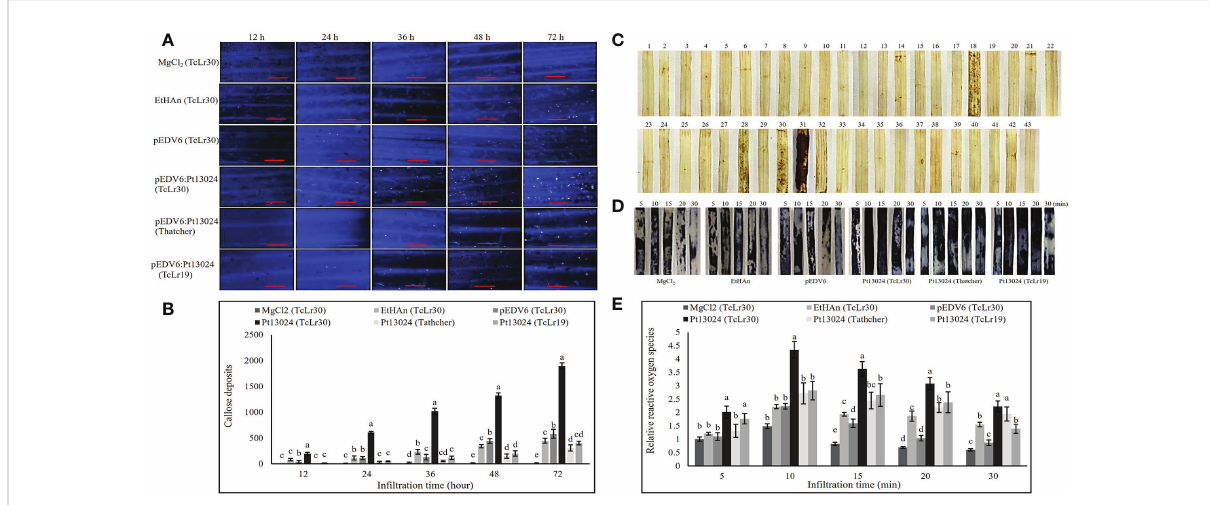
FIGURE 6 Transient expression of Pt13024 stimulated callose deposition and caused a burst of ROS in TcLr30. (A) Callose deposition at different time points after overexpression of Pt13024 in Thatcher, TcLr19, and TcLr30, respectively. The controls were MgCl 2 , EtHAn, and pEDV6. Bar = 100 m m. (B) Callose deposition associated with in fi ltration time. The accumulation of callose deposition was counted by the area using Image-Pro Plus 6.0 software. The area of callose deposition was measured in pixels. (C) The effector proteins were delivered into the Thatcher and 42 wheat leaf rust resistant near-isogenic lines (monogenic lines) by the bacterial type III secretion system. The sequence of wheat materials was 1, Thatcher; 2, TcLr1; 3, TcLr2a; 4, TcLr2b; 5, TcLr2c; 6, TcLr3; 7, TcLr3ka; 8, TcLr3bg; 9: TcLr9, 10: TcLr10; 11: TcLr11; 12, TcLr12; 13, TcLr13; 14, TcLr14a; 15, TcLr14b; 16, TcLr15; 17, TcLr16; 18, TcLr17; 19, TcLr18; 20, TcLr19; 21, TcLr20; 22, TcLr21; 23, TcLr22, 24, TcLr23, 25, TcLr24, 26, TcLr25, 27, TcLr26, 28, TcLr27+31, 29, TcLr28; 30, TcLr29, 31, TcLr30, 32, TcLr32, 33, TcLr33, 34, TcLr34, 35, TcLr35, 36, TcLr37; 37, TcLr38, 38, TcLr41, 39, KS91WGRC11 ( Lr42 ), 40, TcLr44, 41, TcLr45, 42, TcLr47; and 43, TcLr51. DAB was used to stain, and the phenotypic after decolorization is shown. (D) ROS bursts at different time points after overexpression of Pt13024 on Thatcher, TcLr19, and TcLr30. NBT was